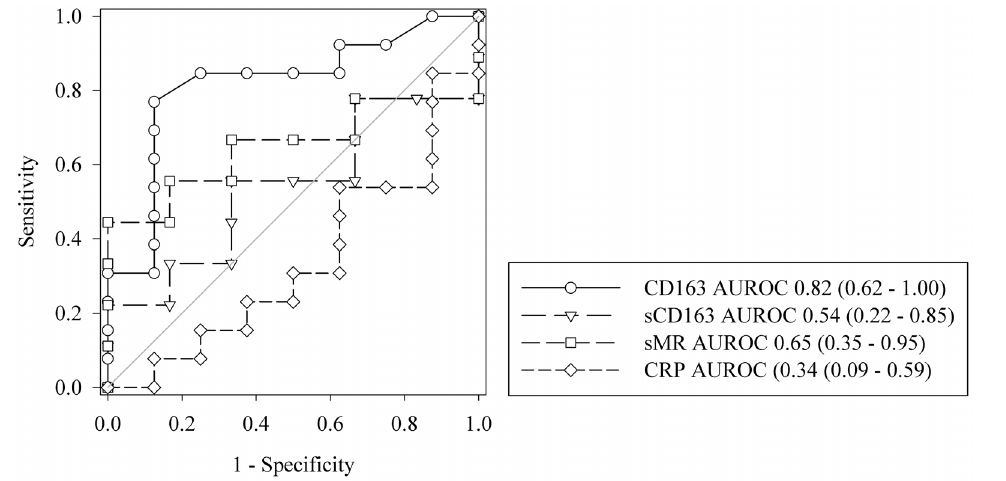
Figure 4. Receiver operating characteristic curve analysis and the ability to discriminate between survivors and non-survivors among the septic patients at ICU admission. Area under the receiver operating characteristic curve (AUROC) is shown for monocyte-bound CD163, sCD163, sMR, and plasma CRP. Numbers in parentheses are 95% confidence intervals.